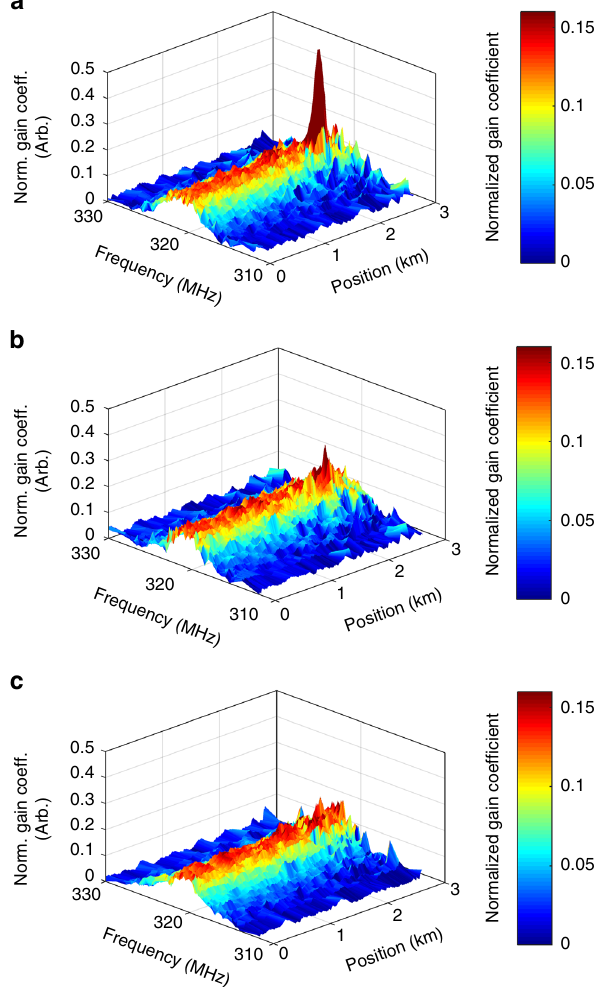
R γ 7 ð Þ Ω ; z ð Þ d Ω